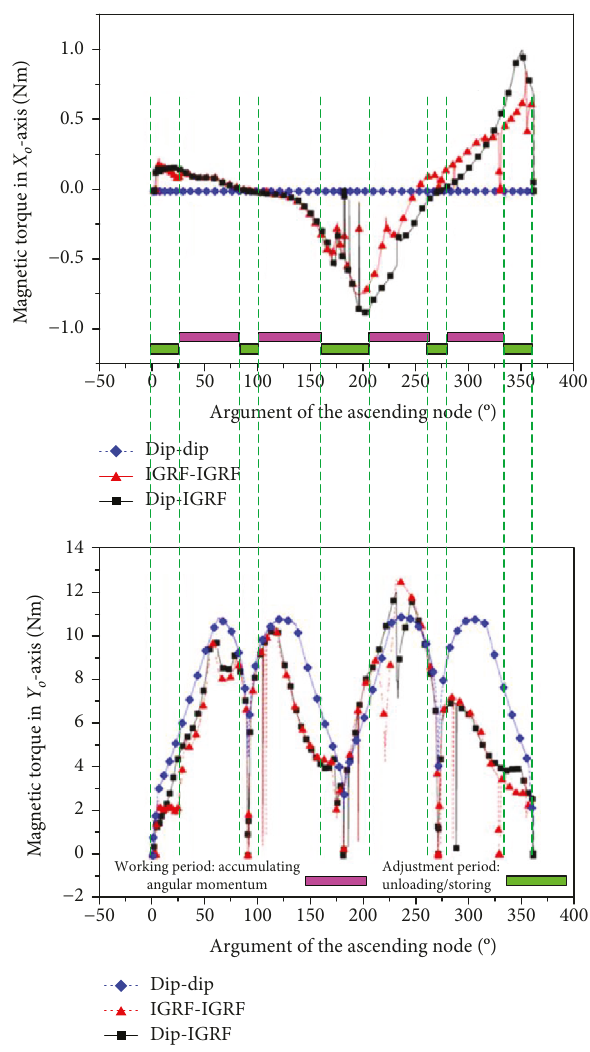
Figure 16: Diagram of a simple programming SAMA